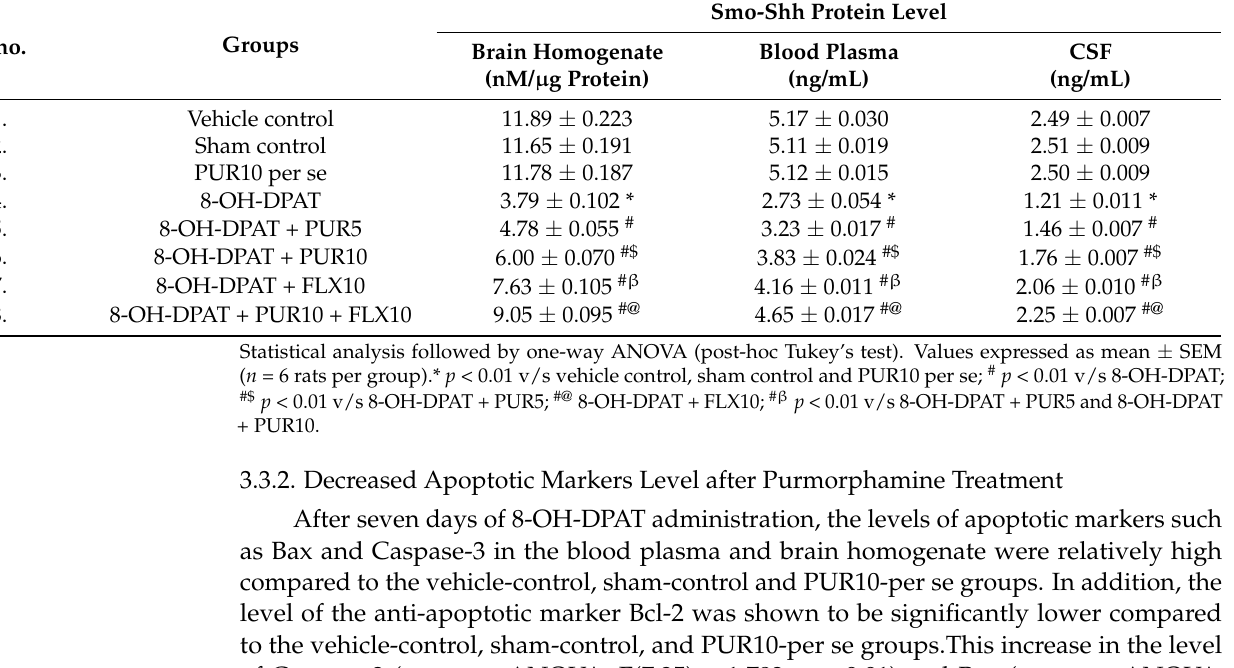
Table 1. Effect of purmorphamine on the restoration of Smo-Shh level in 8-OH OCD.